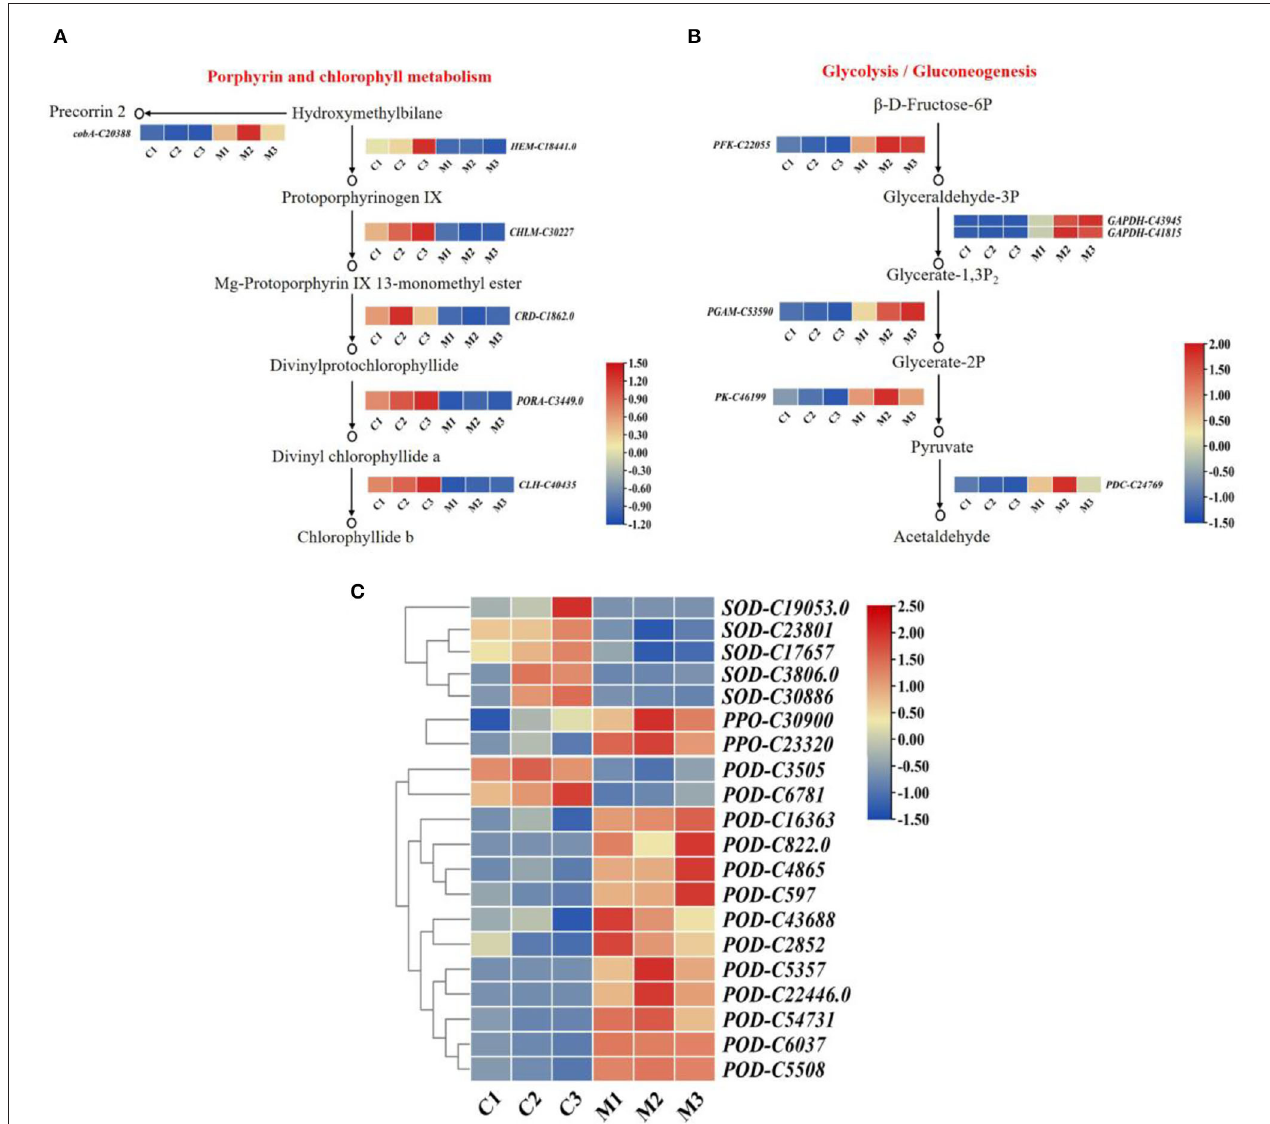
FIGURE 6 | The expression patterns of DEGs. (A) The expression patterns of DEGs involved in porphyrin and chlorophyll metabolism pathway in M. microcarpa . (B) The expression patterns of DEGs involved in glycolysis/gluconeogenesis pathway in M. microcarpa . (C) Heat map depicting the expression patterns of antioxidant enzyme-related DEGs in M. microcarpa . Changes in expression level are indicated by a change in color, blue indicates a lower expression level, whereas red indicates a higher expression level. C, samples treated at 25 ◦ C; M, samples treated at − 2.8 ◦